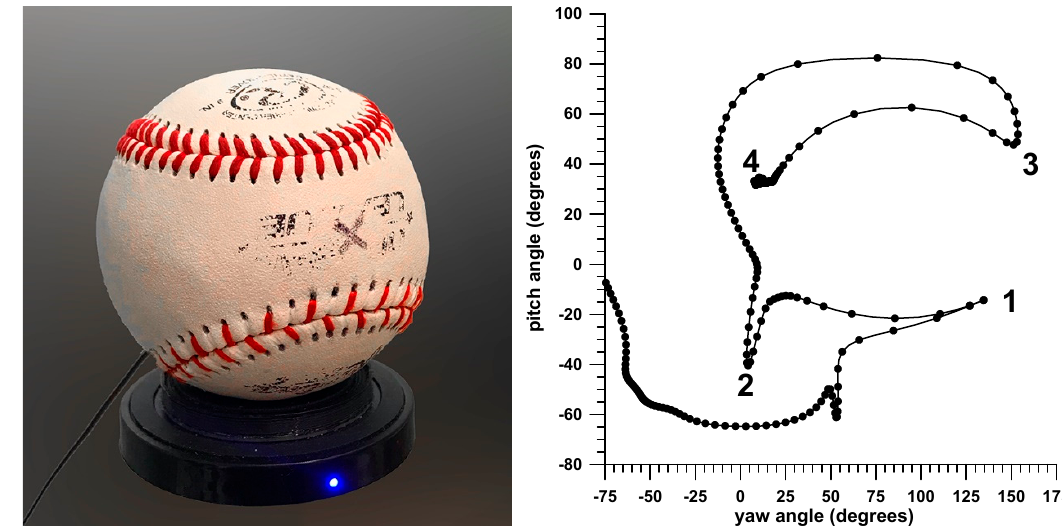
Figure 1. ( left ): smart baseball on charging dock; ( right ): pitch angle against yaw angle of the spin axis (angular velocity vector); the graph shows how the spin axis moves on the surface of the ball; the dots represent the position of the spin axis at a frequency of 407.5 Hz (the greater the distance between the dots, the faster the spin axis moves across the ball’s surface); 1, 2, 3 = change of direction of the spin axis; 4 = spin axis at